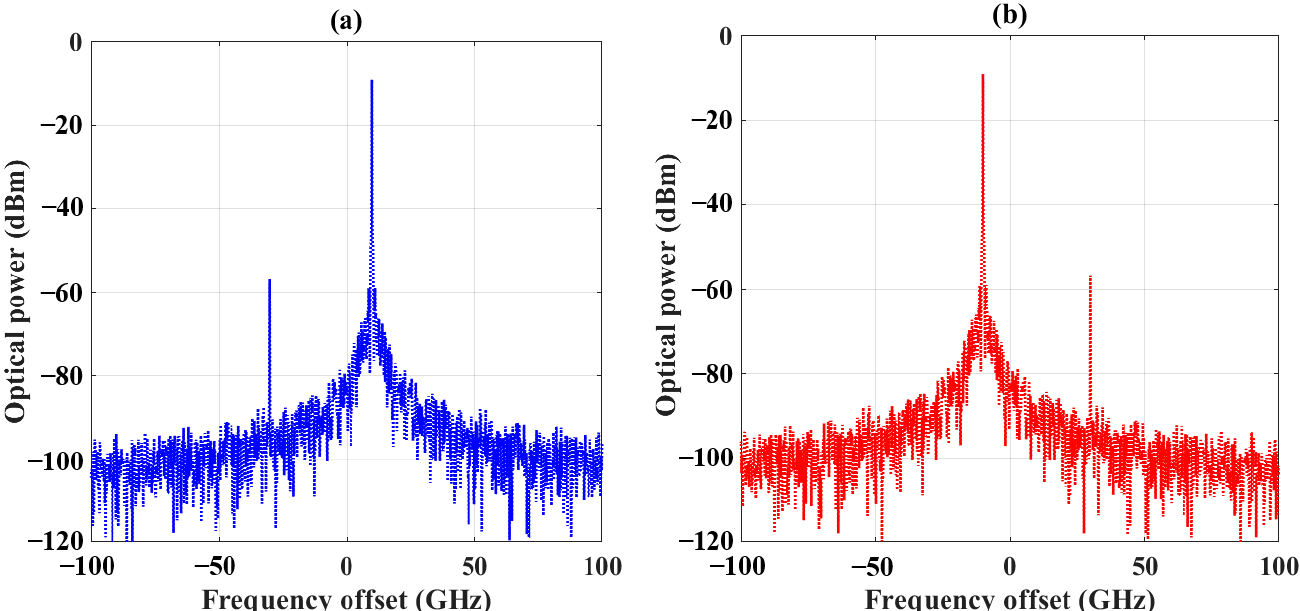
Figure 3. Optical spectra due to ( a ) frequency up-conversion, and ( b ) frequency down-conversion. The RF frequency and reference frequency are 10 GHz and 193.4125 THz, respectively. Simulation is carried out using Virtual photonics Inc. (VPI) software package.